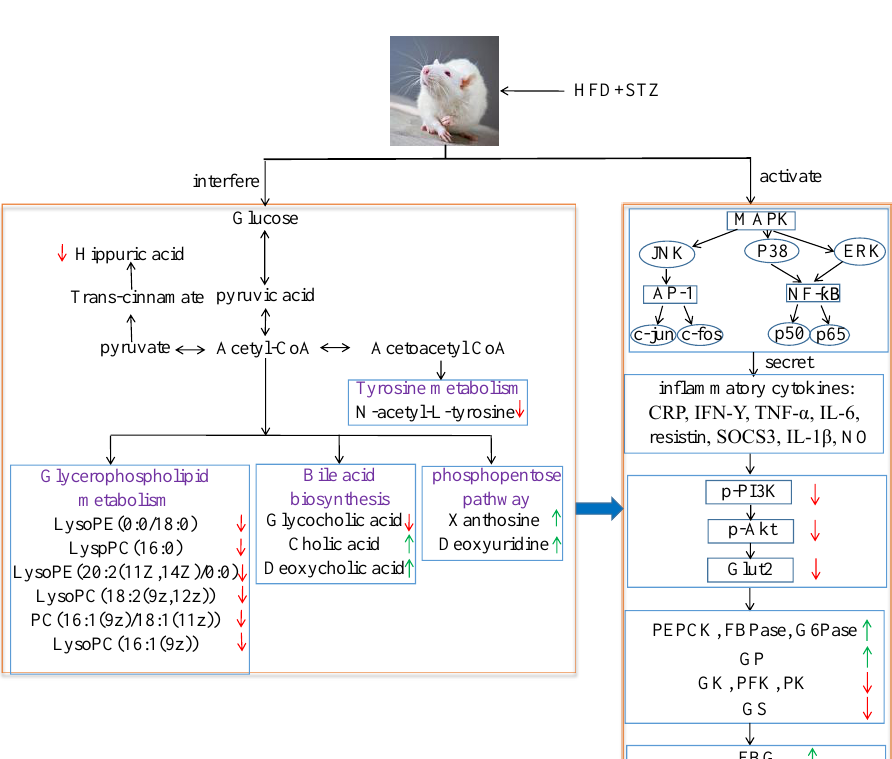
Figure 10. Correlation networks of main potential biomarkers in response to T2DM rats. Compared with the normal group, the red arrows represent the decrease of the contents of endogenous metabolites, while the green arrows represent the increase of the contents of endogenous metabolites.